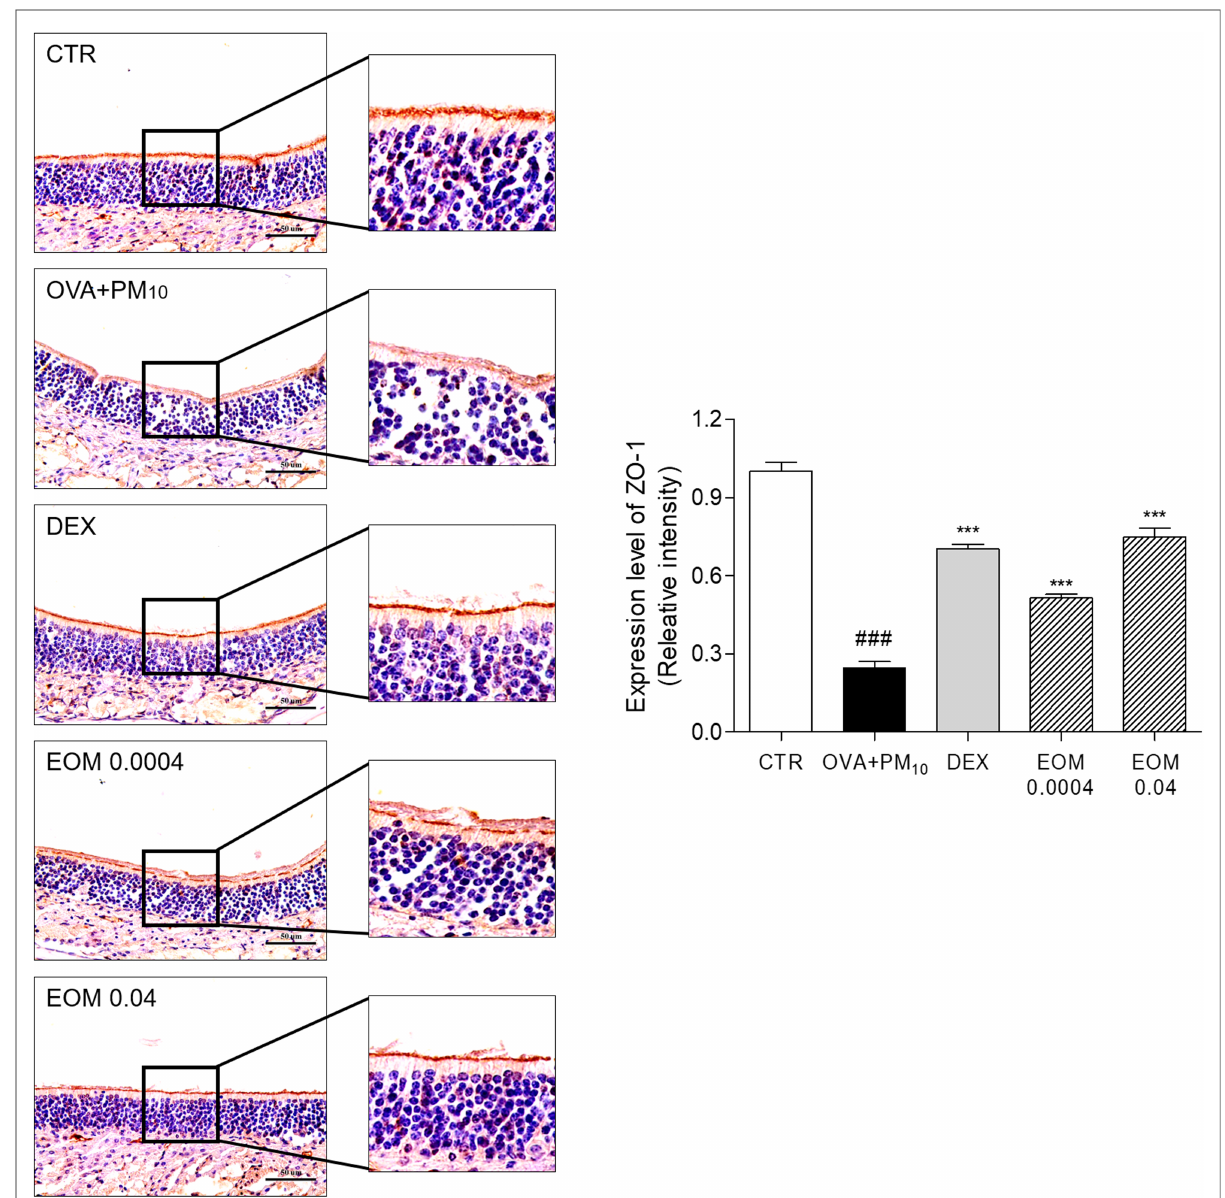
FIGURE 5 The effects of EOM on intracellular junctional proteins of nasal mucosa evaluated by immunohistochemistry. Nasal septum tissues were stained with IHC in OVA and PM10-induced mice. EOM (0.0004, 0.04% v/v orally) was given to OVA and PM10-induced allergic rhinitis. Results are presented as mean±standard error of the mean. ### p <0.001 vs. CTR group * p <0.05, ** p <0.01 and *** p <0.001 vs. OVA and PM10-treated group. CTR, control; EOM, essential oils from the Mentha piperita leaf ; OVA, ovalbumin; IHC,